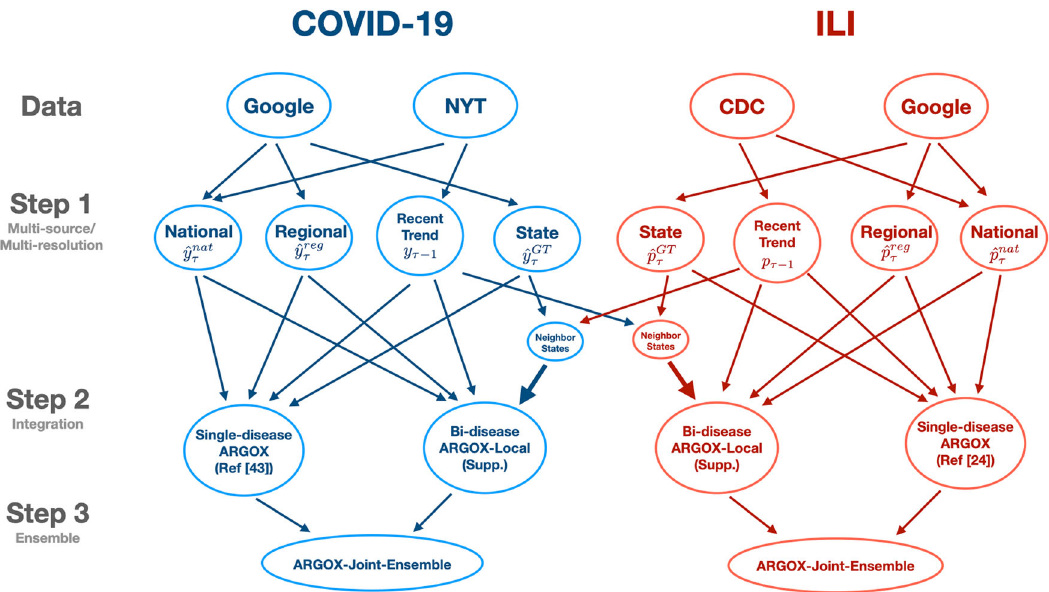
Fig. 2 Flow Chart of the proposed ARGOX-Joint-Ensemble. The top-to-bottom procedure of ARGOX-Joint-Ensemble is presented, starting with raw data input and ending with state-level forecasting outputs. The procedures to forecast COVID-19 cases/deaths are in color blue (left), and the procedures to forecast %ILI is in color red (right). Google: Google search data; NYT: New York Times published COVID-19